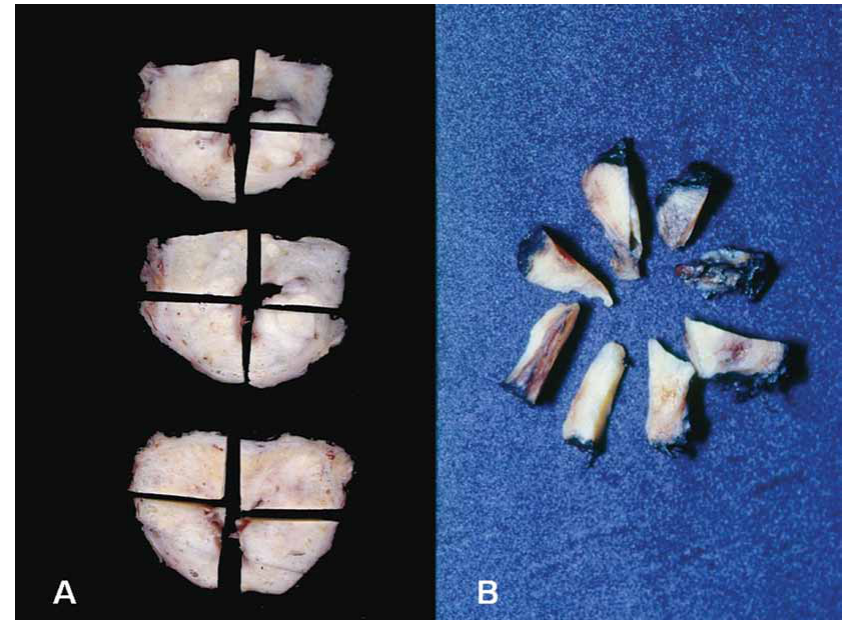
Figure 1. (A) Three transversal sections of the prostate specimen subdivided into 2 anterolateral and 2 posterolateral qua- drants. (B) Eight sections from the bladder neck using the cone